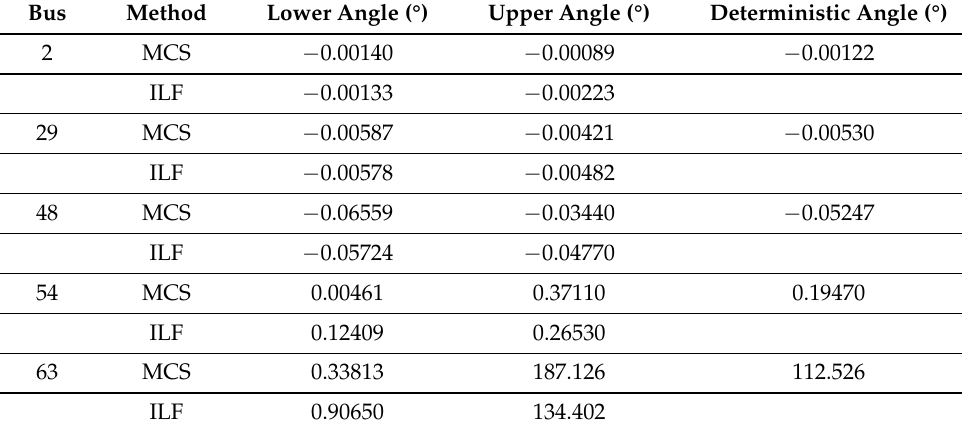
Table 3. Phase Angle—IEEE 69-bus test system.